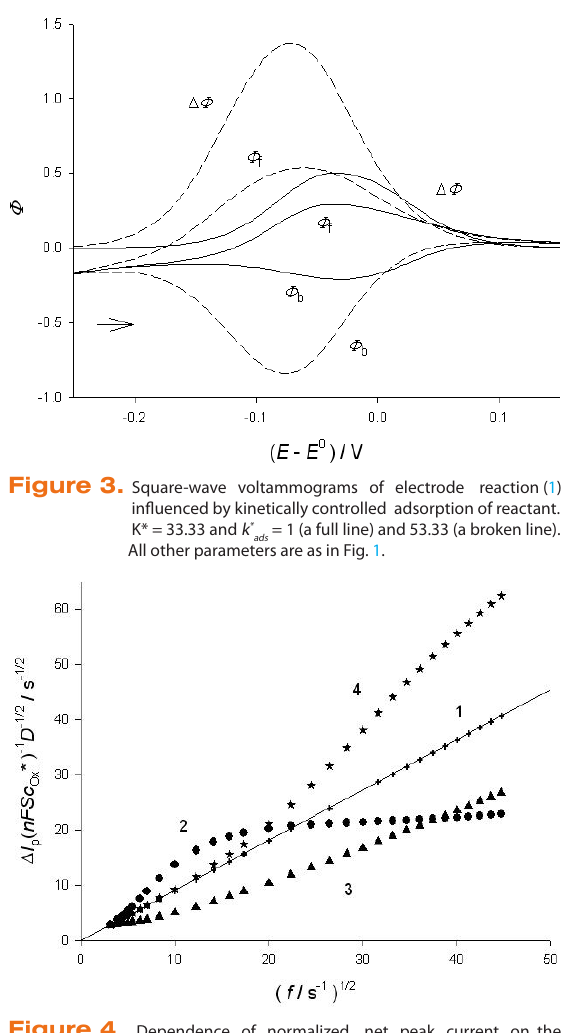
Figure 4. Dependence of normalized net peak current on the these two responses are similar and no information on square-root of frequency. K = 0.01 cm, k / cm s -1 > ads 10 4 (1), = 1.6 (2), 0.03 (3) and 30 (4). All other parameters are as in Fig. 1. square-wave voltammogram, particularly if the Fig. 2 shows relationships between dimensionless